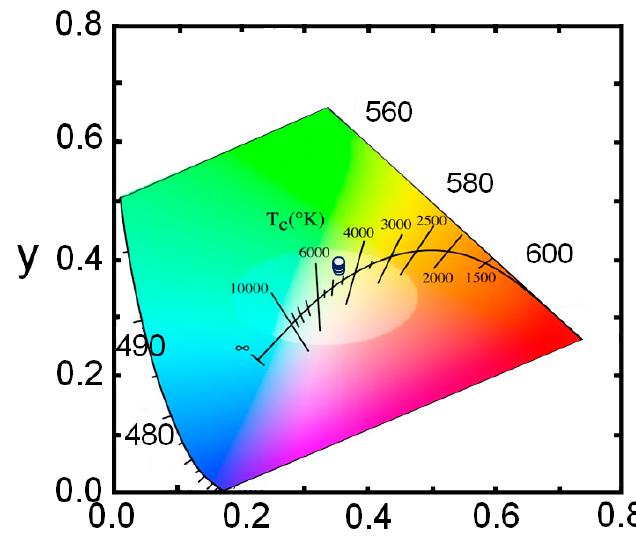
Figure 6. The 1931 Commission International l’Eclairage chromaticity diagram presents stable white light emission characteristics of the phosphor-free white-color InGaN/AlGaN nanowire μ LED.